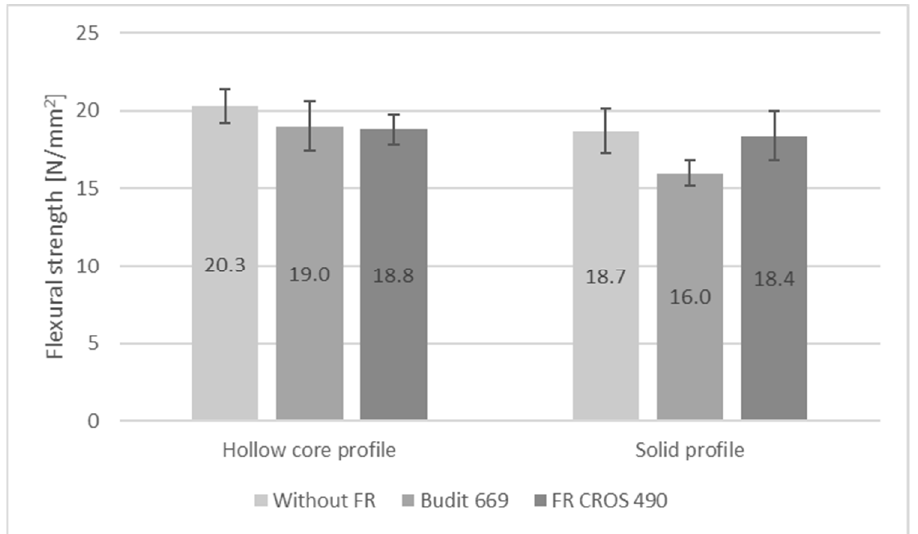
Figure 9. Flexural strength of co-extruded profiles with and without fire-retardants. No requirement provided in DIN EN 15534-5. Test performed according to EN 310 with support span of 500 mm and test specimen length of 600 mm.